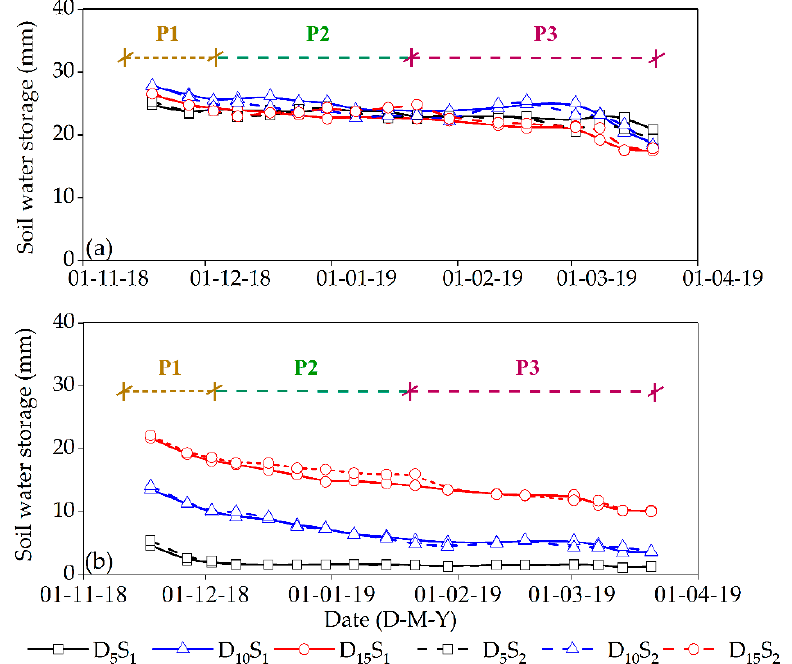
Figure 9. Soil water storage of the ( a ) whole sand-layered soil columns; and ( b ) the overlying layer. For D 5 S 1 and D 5 S 2 , the total evaporation was 8.2 and 8.3 mm, and the reduction of soil Table 4. The reduction of soil water storage in the overlying layer and the whole sand-layered soil columns (unit: mm).